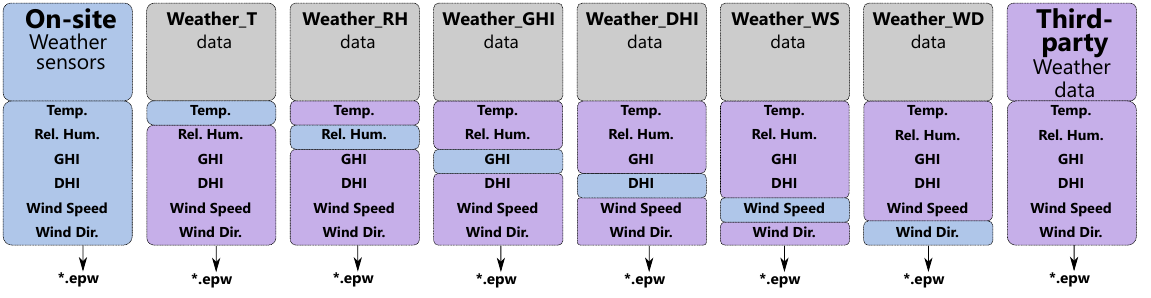
Figure 4. Weather explanation and objectives of the